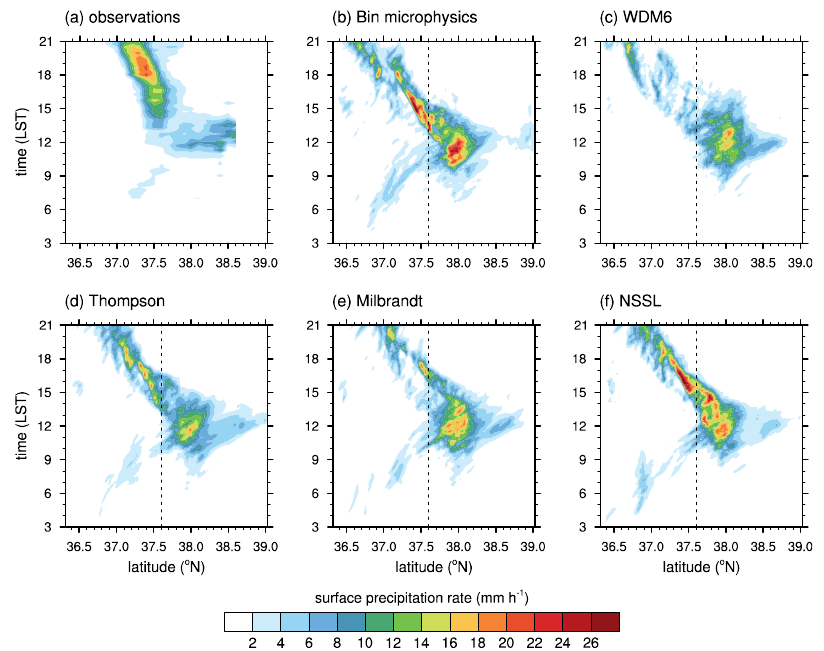
Figure 3. Latitude–time diagrams (Hovmöller diagrams) of surface precipitation rate averaged along the longitudinal direction ( a ) observed at AWSs and obtained using the ( b ) bin microphysics scheme, ( c ) WDM6 scheme, ( d ) Thompson–Eidhammer scheme, ( e ) Milbrandt scheme, and ( f ) NSSL scheme. Dashed lines in ( b – f ) are the rough dividers that divide the northern precipitation and the southern precipitation. Note that the observed surface precipitation north of ~38 ◦ N is not representative of real precipitation, attributable to the lack of